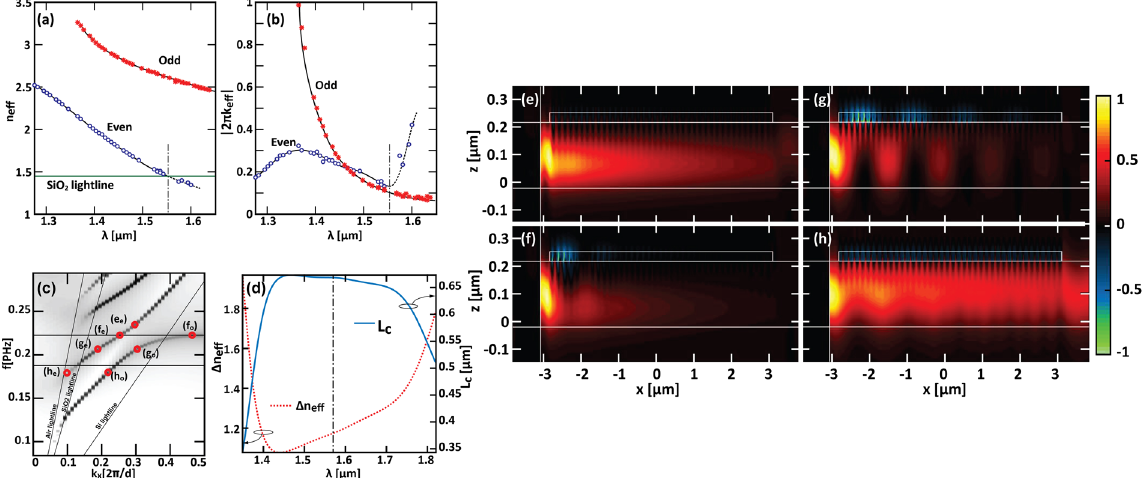
Figure 2. ( a ) Dispersion and ( b ) absorption curves when a coupler having 50 MNP is considered. In ( a ) the SiO 2 substrate lightline is superimposed (green horizontal line). The vertical black dash-dotted line indicates the wavelength where the n eff of the even mode crosses the aforementioned lightline. ( c ) Coupled device band structure. ( d ) Supermodes effective refractive index mismatch (red dotted curve) and corresponding coupling length (solid blue curve) calculated as a function of the wavelength (e-h) Self-normalized y -component of the Poynting vector for y = 0 calculated at ( e ) λ = 1.275 μ m ( f = 0.235 PHz), ( f ) λ = 1.350 μ m ( f = 0.22 PHz), ( g ) λ = 1.450 μ m ( f = 0.207 PHz) and (h) λ = 1.651 μ m ( f = 0.182 PHz). In ( c ) the frequencies corresponding to the distribution reported in ( e – h ) are highlighted by red circles. The two superimposed horizontal black lines delimit the zone where the two supermodes contemporarily exist as guided modes. These maps correspond to the states highlighted in ( c ) by red